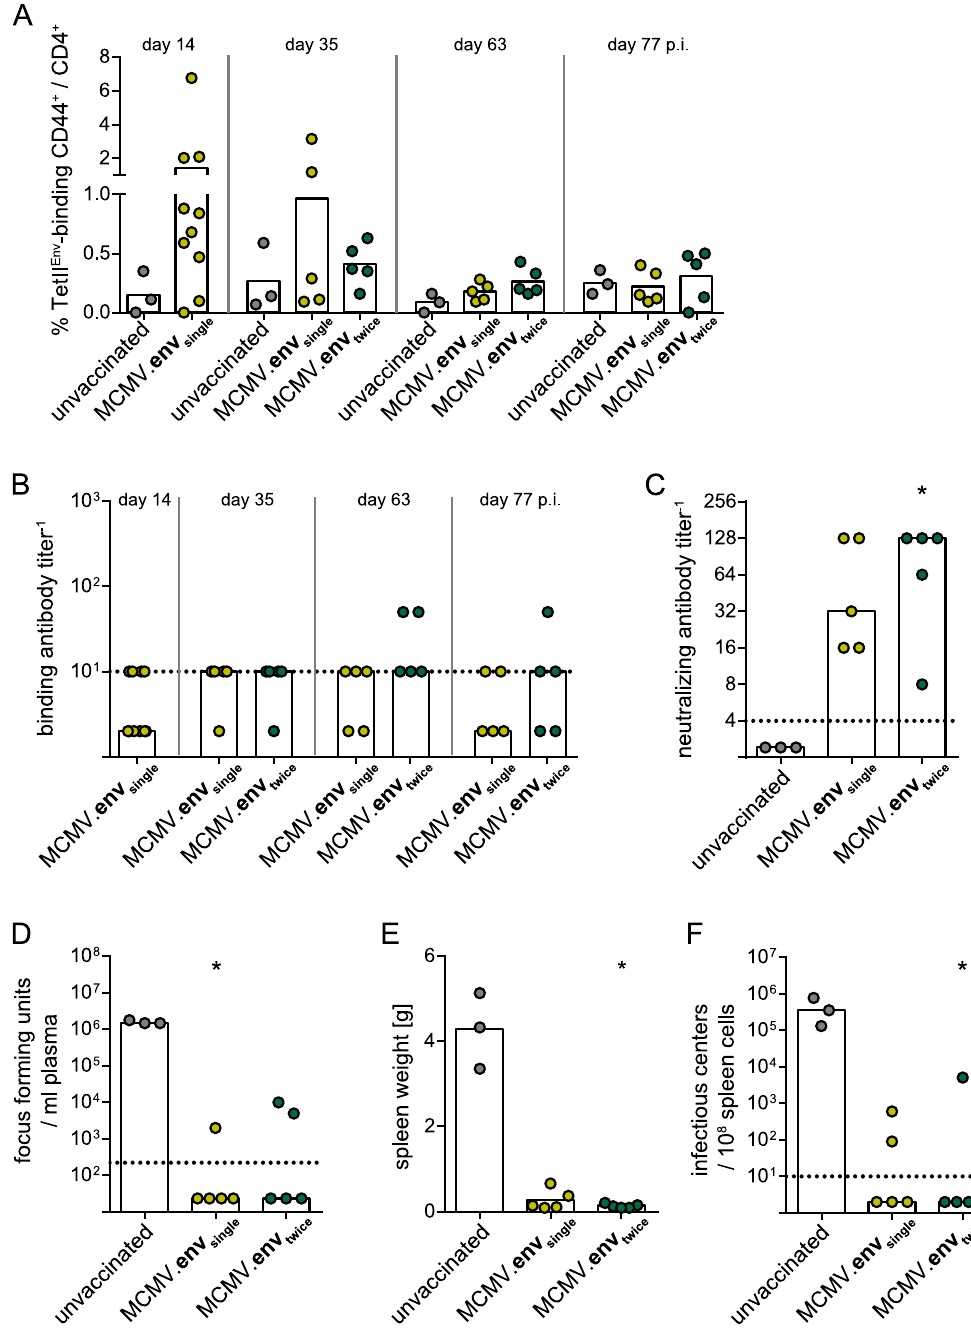
Fig 12. MCMV.env immunization confers long-lasting protection. CB6F1 mice were immunized once or twice in a three- week interval, and infected with 5 000 SFFU FV 12 weeks after the first immunization. The Env-specific CD4 + T cell response (A) and binding antibody titers (B) were monitored over time. The neutralizing antibody response (C) and viral loads in plasma (D) were analysed ten days after FV infection, spleen weights (E) and spleen viral loads (F) were analysed three weeks after FV infection. Data were obtained in one experiment, each dot indicates one mouse, bars indicate mean (A, E) or median values (B-D, F), dotted lines indicate the limits of detection. Statistically significant differences compared to unvaccinated mice are indicated by � ( P < 0.05, One Way ANOVA on Ranks, Dunn’s post test).